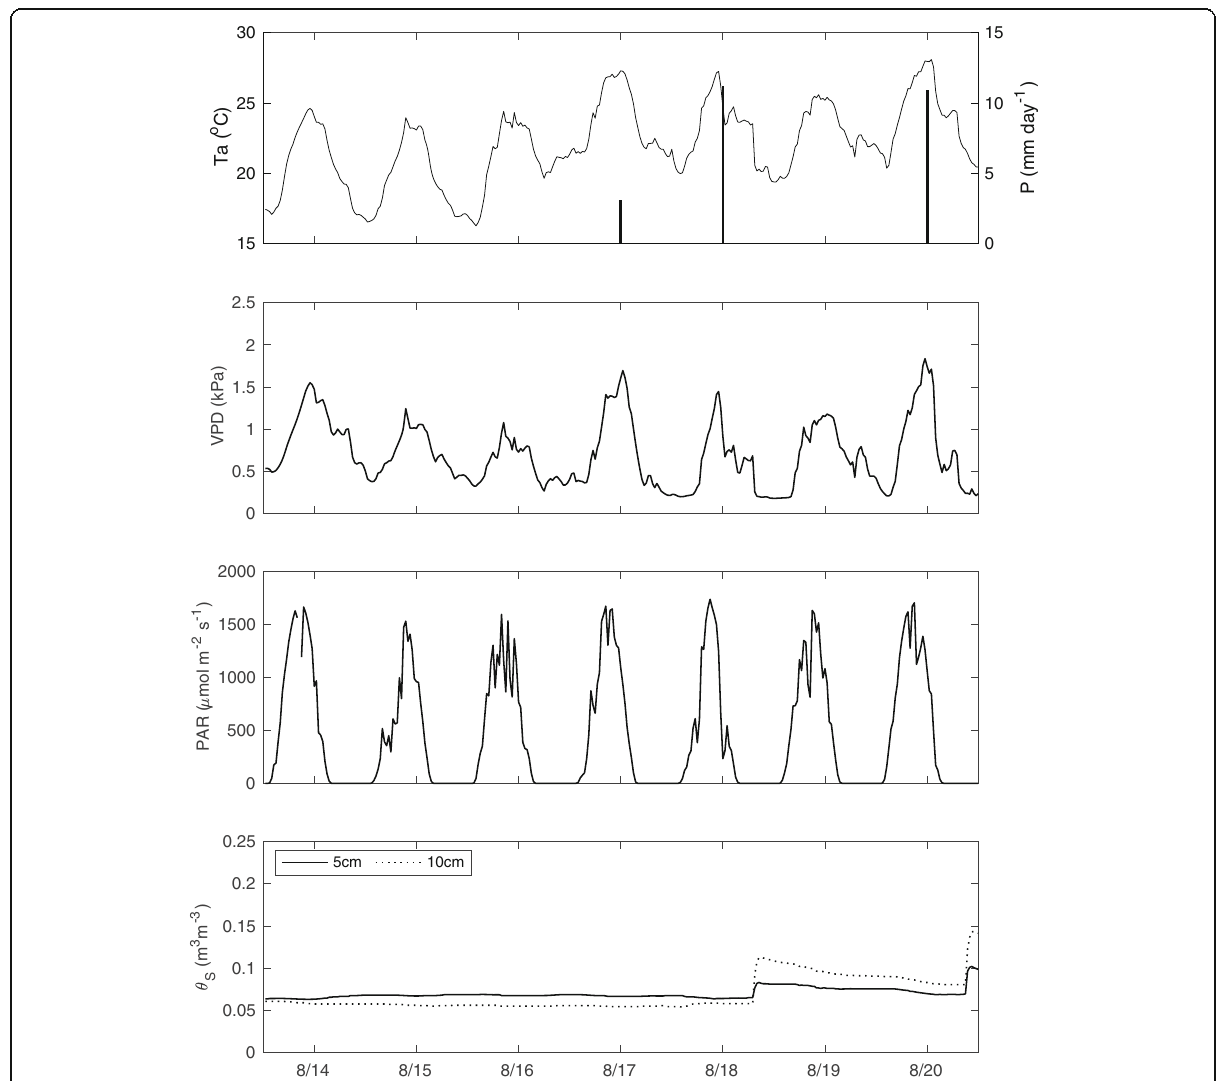
Fig. 1 Meteorological measurements of a air temperature (Ta) and precipitation (P), b vapor pressure deficit (VPD), c photosynthetically active radiation (PAR), and d soil water content ( θ ) from August 14 to 20,